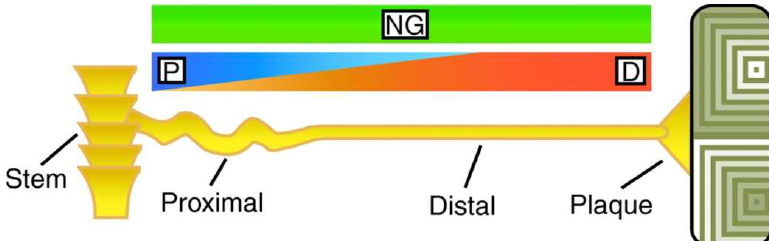
6 of 37 Figure 2. Visual summary of the slippery liquid-infused porous surfaces (SLIPS) approach. ( A ): SLIPS fabrication flow chart; ( B , C ): fluorescence micrographs of attached P. aeruginosa biofilm on SLIPS (B) and superhydrophobic Teflon (C) under the same conditions; ( D , E ): wetting characteristics of a drop- cast biofilm of P. aeruginosa on SLIPS (D; limited wetting, loosely attached and easily removable) and superhydrophobic Teflon (E; complete wetting, high adhesion); ( F ): comparison of biofilm attachment on a SLIPS surface (after 7 days) and on a PEGylated surface (after only 5 h), showing a 30-fold increase in anti-biofilm capacity for SLIPS against a gold-standard antifouling material. Reproduced from reference [34], with permission. 3. Mussel - Inspired Synthetic Polymers and Catechol - Mediated Adhesion